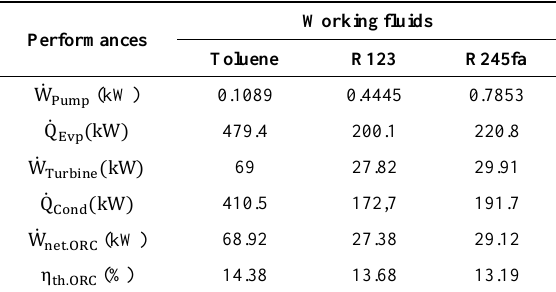
Table 2. Thermodynamic performance of the ORC